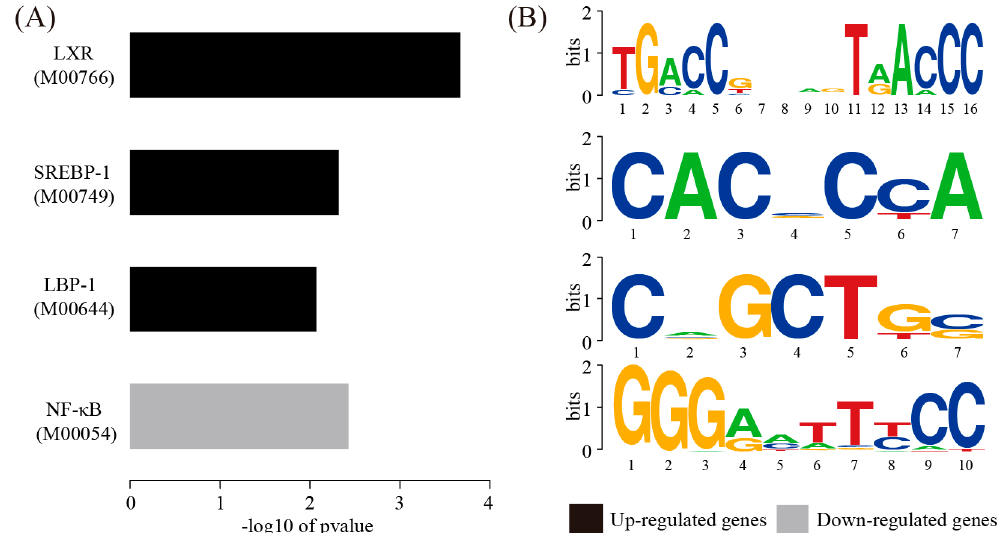
Figure 4. Analysis of transcription factor binding sites. ( A ) Transcription factor analysis performed on the upregulated genes and downregulated genes, respectively; ( B ) The sequence logo for enriched transcription factors.